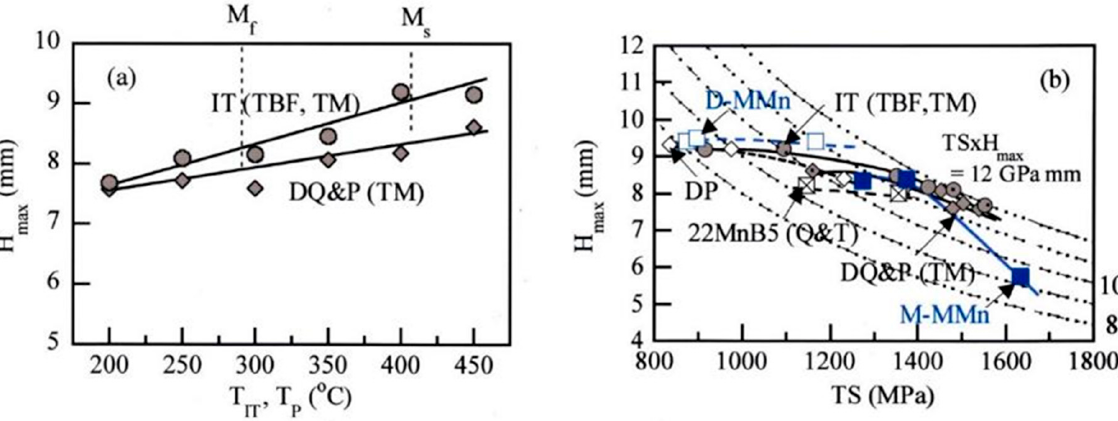
Figure 12. ( a ) Isothermal transformation ( T IT ) and partitioning temperature ( T P ) dependences in maximum stretch height ( H max ) in 0.20C-1.50Si-1.50Mn-0.05Nb TBF and TM steels subjected to iso-